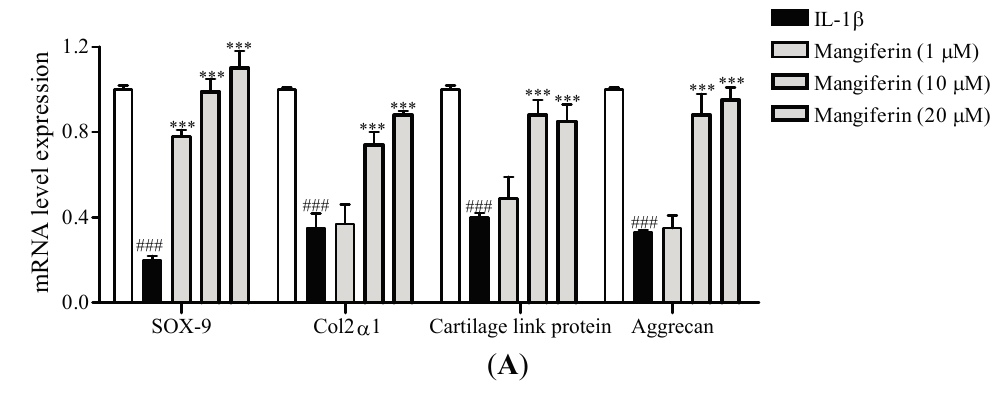
Figure 4. Effects of mangiferin on the expression of anabolic and catabolic genes in IL-1 β -stimulated mesenchymal stem cells (MSCs). ( A ) mRNA expression levels of the chondrogenic markers SOX9, Col2 α 1, cartilage link protein, and aggrecan. MSCs pellet culture was treated with mangiferin (1, 10, and 20 µM) for 7 days. mRNA expression was measured by real time RT-PCR and normalized relative to β -actin; ( B ) mRNA expression levels of TGF- β , BMP-2, and BMP-4; and ( C ) mRNA expression levels of MMP-1, MMP-13, and ADAMS5. Data were obtained from three independent experiments and are represented as mean ± SEM. ### p < 0.001 compared with control. ** p < 0.01, and *** p < 0.001 compared with IL-1 β